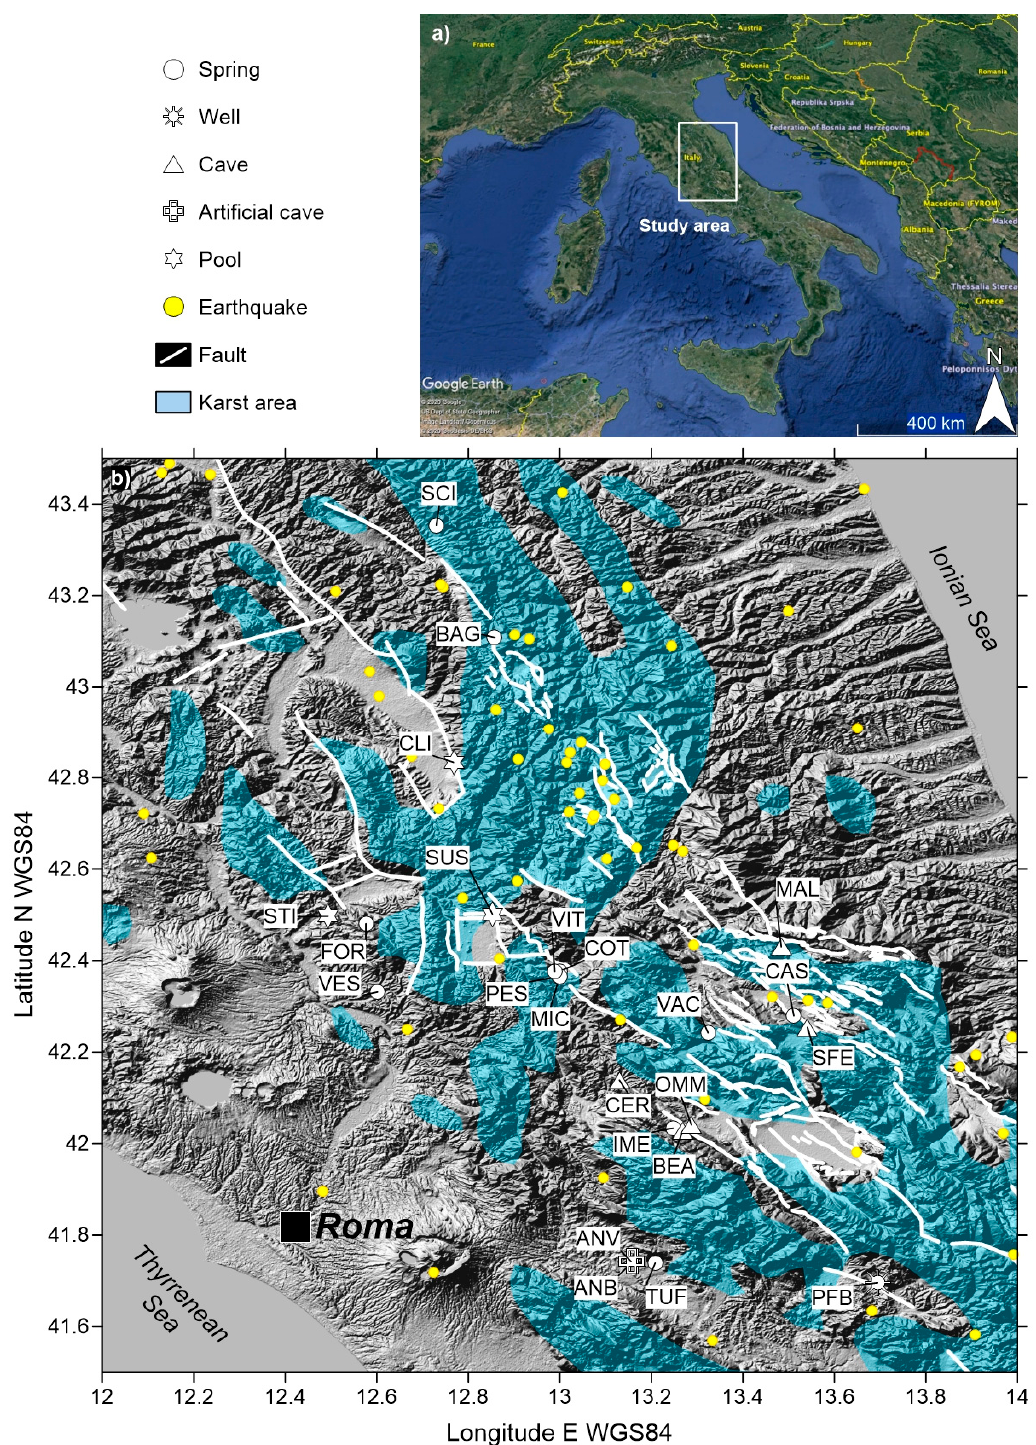
Figure 1. ( a ) Location and ( b ) details of the studied area reporting sampling sites, epicenters of the main earthquakes occurred between the 5th Century B.C. and 1997 A.D. [24], traces of main faults able to generate seismicity [25] and boundaries of the main karst areas [26].